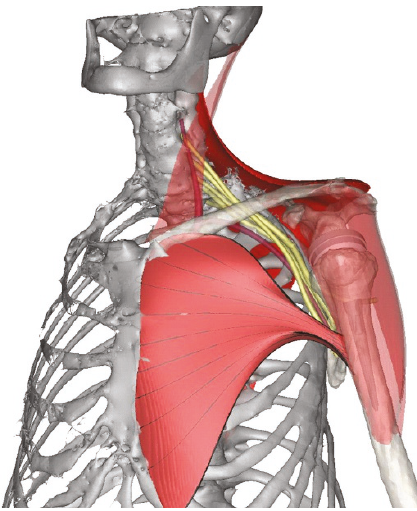
Figure 9: Postoperative reconstruction with a reversed shoulder prosthesis in situ. Reconstruction of the brachial plexus, brachial artery and surface reconstruction of the sternocleidomastoideus, deltoid, pectoralis major (with fibre directions) and